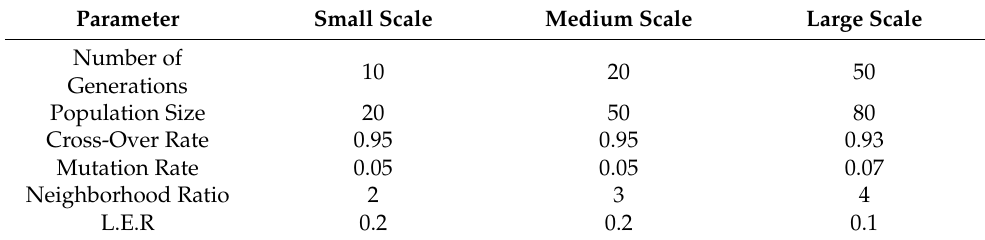
Table 7. The estimated setting values for the proposed NSGA-II method.